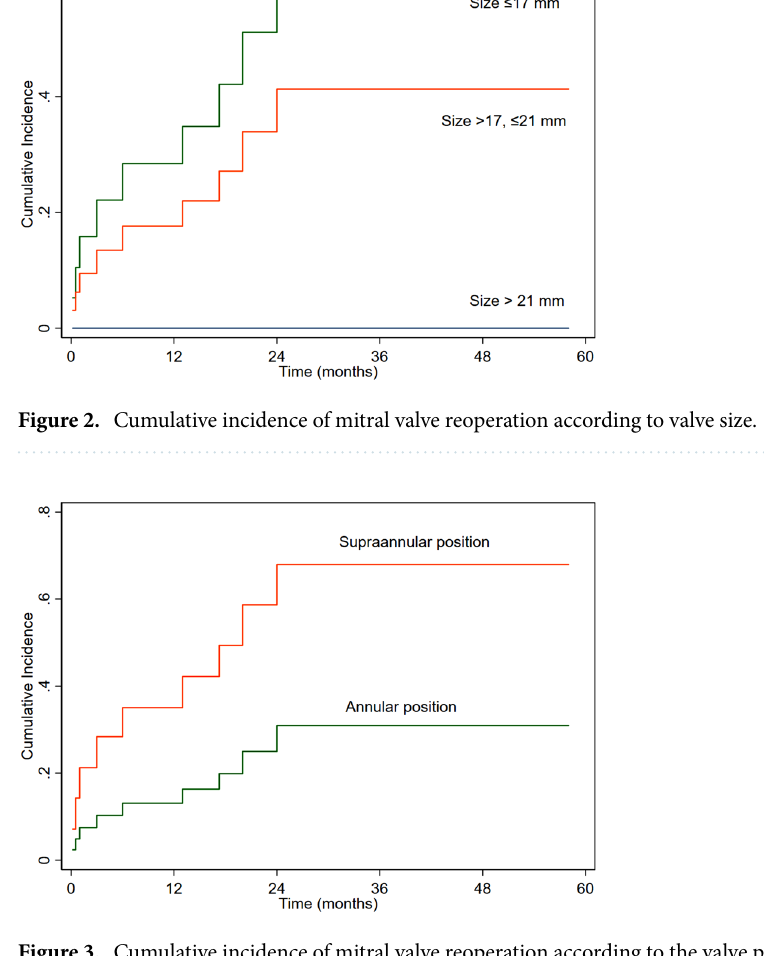
Figure 3. Cumulative incidence of mitral valve reoperation according to the valve position.